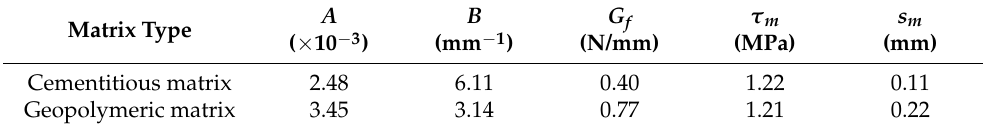
Figure 10. Bond-slip models. Table 4. Parameters of the bond-slip